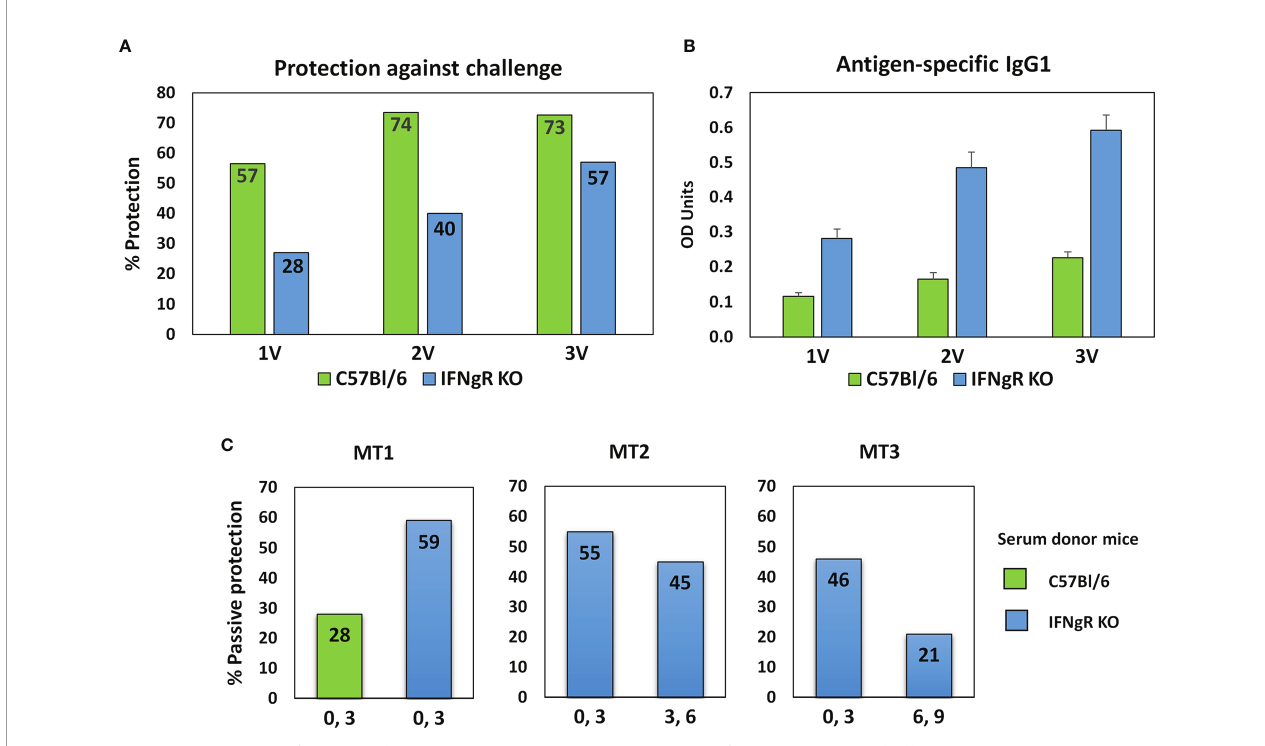
FIGURE 2 | Properties of sera from IFNgR KO mouse used to screen the arrays. (A) Percent protection of C57Bl/6 versus IFNgR KO mice given one, two or three vaccinations with 500 radiation-attenuated cercariae and then challenged 5 weeks later with 200 normal cercariae. (B) Antigen speci fi c IgG1 antibody levels in sera recovered from these mice 14 days after each vaccination. (C) Passive protection against a 200 cercarial percutaneous challenge of naïve C57Bl/6 recipients given injections of serum recovered from 3x vaccinated C57Bl/6 or IFNgR KO mice on the designated days. MT2 and MT3 sera were used to screen the four peptide